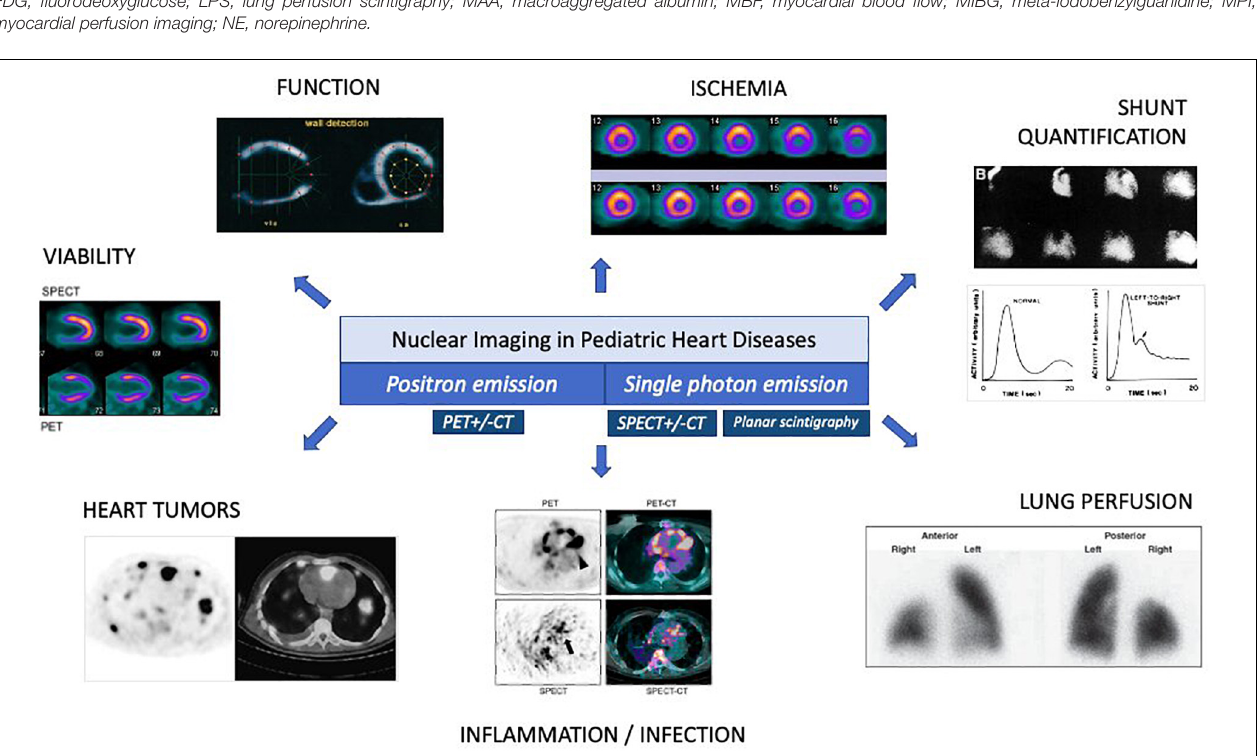
sinus of Valsalva (AAOCA), associated with intramural or interarterial course, is increasingly diagnosed incidentally in children, but the related clinical risks are not well defined